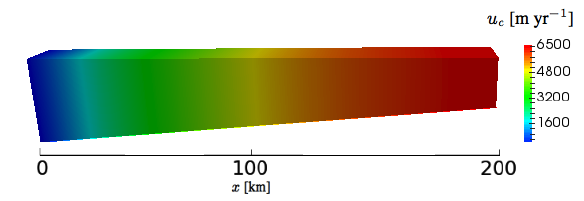
Figure 3. Horizontal velocity u c (myr − 1 ) from coupled model for the 3-D ice shelf ramp with x c = ( 100 ,y)